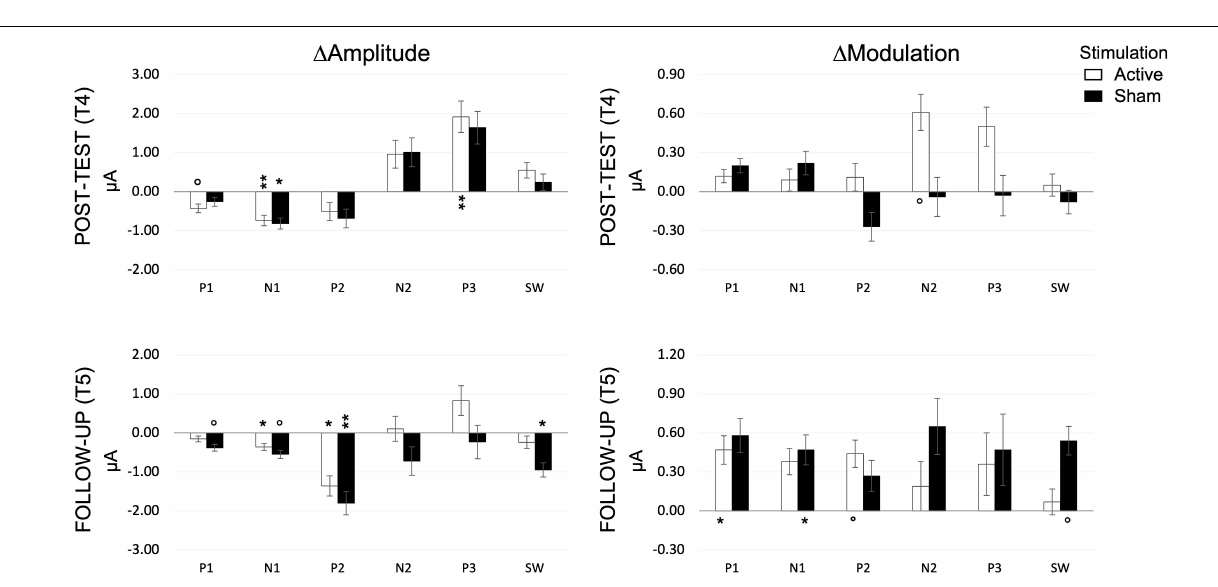
FIGURE 10 | Amplitude and modulation changes at post-test (T4) and follow-up (T5), for each component, as measured during the SNBACK task. P -values are indicated as follows: ◦ p < 0.1, * p < 0.05, ** p <